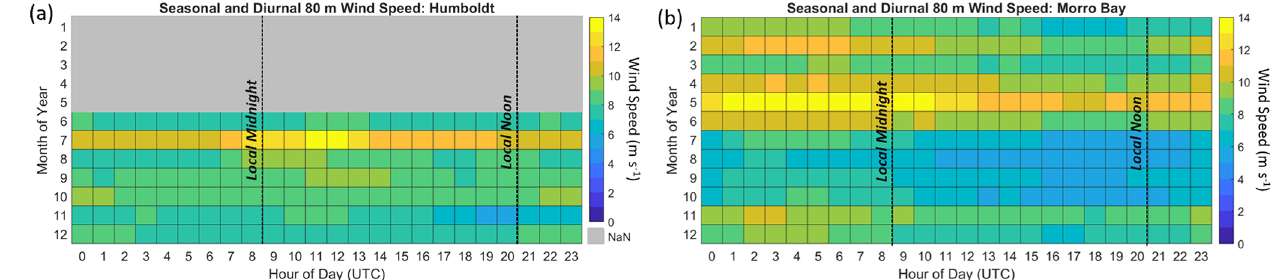
Figure 11. (a,b) Seasonal and diurnal 80m wind speed at Humboldt and Morro